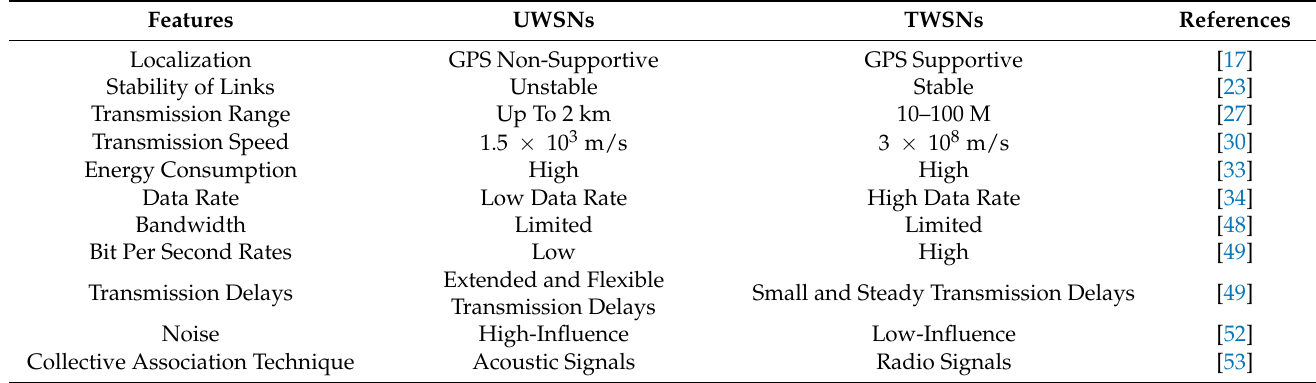
Table 3. Main differences among the characteristics of TWSNs and